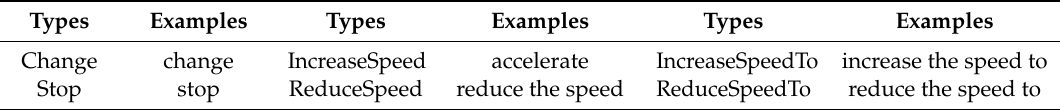
Table 9. Categories of v2 (verbs that should be executed immediately).